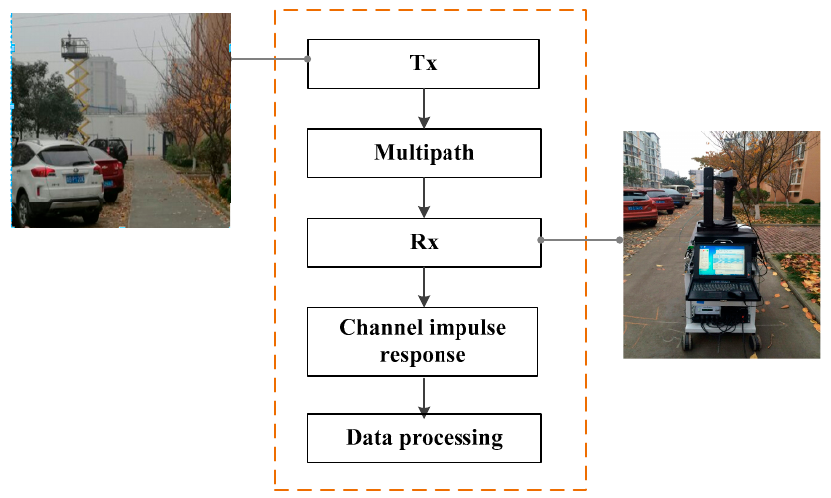
Figure 7. Flow chart outlining the data